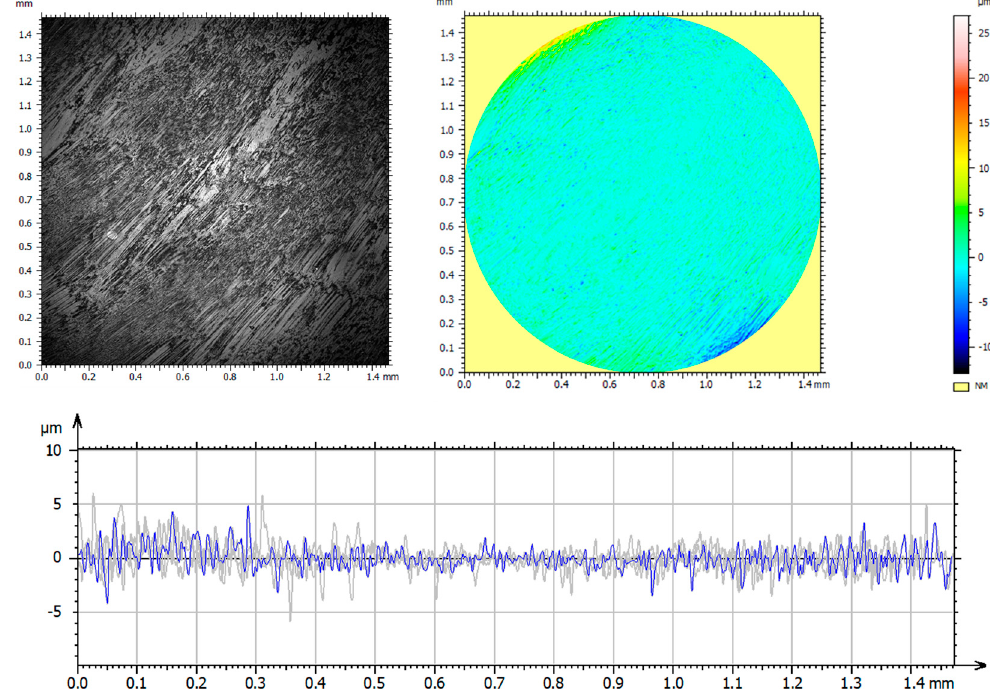
cross-section after the RS-lubricated sliding of the steel 316L—Al 2 O 3 friction pair.